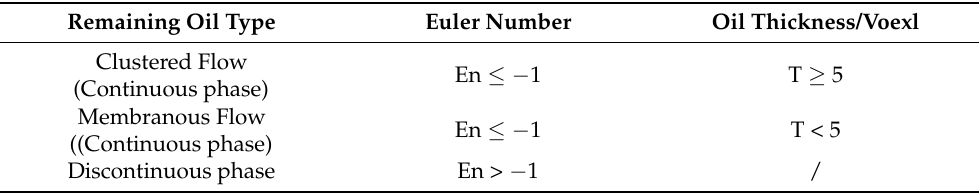
Table 2. This is a table. Tables should be placed in the main text near to the first time they are cited.